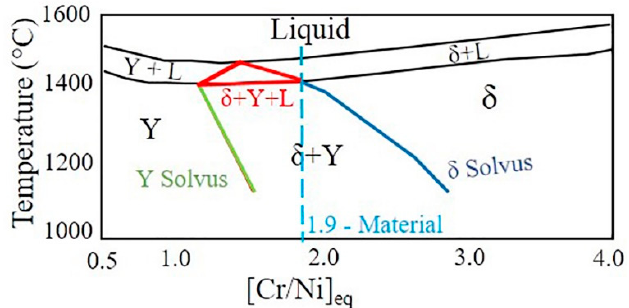
Figure 3. Identification of the expected solidification path in the fusion zone of the material used in this study.